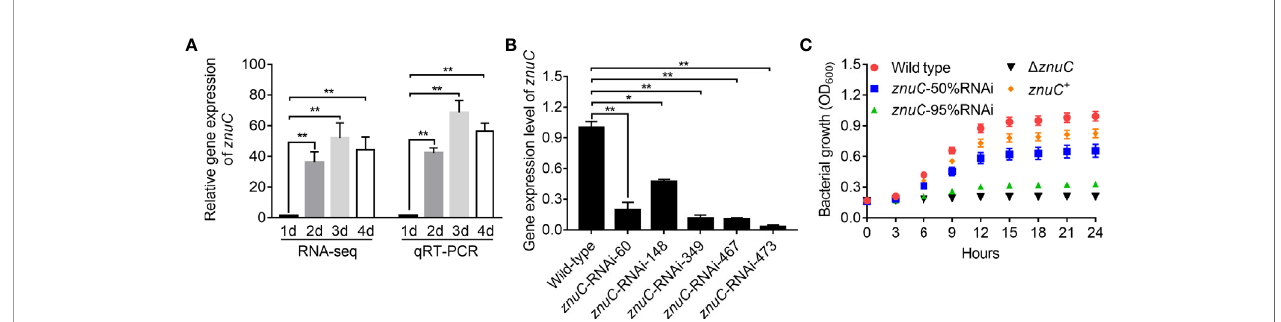
FIGURE 2 | ZnuC is essential for Pseudomonas plecoglossicida growth under Zinc (Zn) limiting conditions. (A) Expression of znuC during infection was determined by dual RNA-seq and quantitative real time PCR (qRT-PCR). (B) To characterize znuC ’ s function, fi ve znuC -RNAi strains were constructed, and the silencing ef fi ciencies were validated by qRT-PCR. (C) To validate whether the znuC in P. plecoglossicida is important for growth during Zn limitation, growth of wild type, znuC -50%RNAi, znuC -95%RNAi, D znuC and znuC + strains were compared in Zn-limiting condition with 2 m M TPEN. gyrB was used as a reference gene in the qRT- PCR analysis. Values are mean ± SD (n = 3, * P < 0.05, ** P <